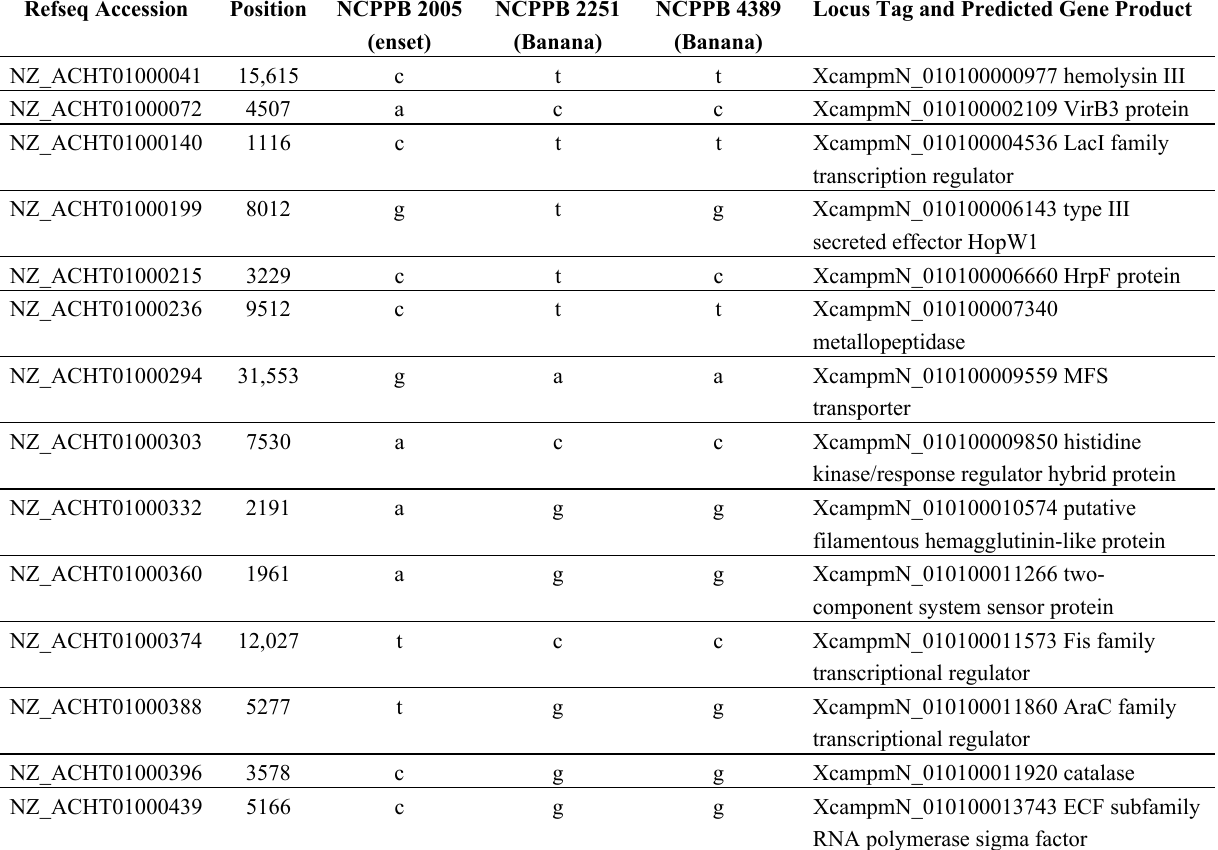
Table 4. Examples of non-silent single-nucleotide polymorphisms that distinguish NCPPB2251 from banana versus NCPPB2005 from